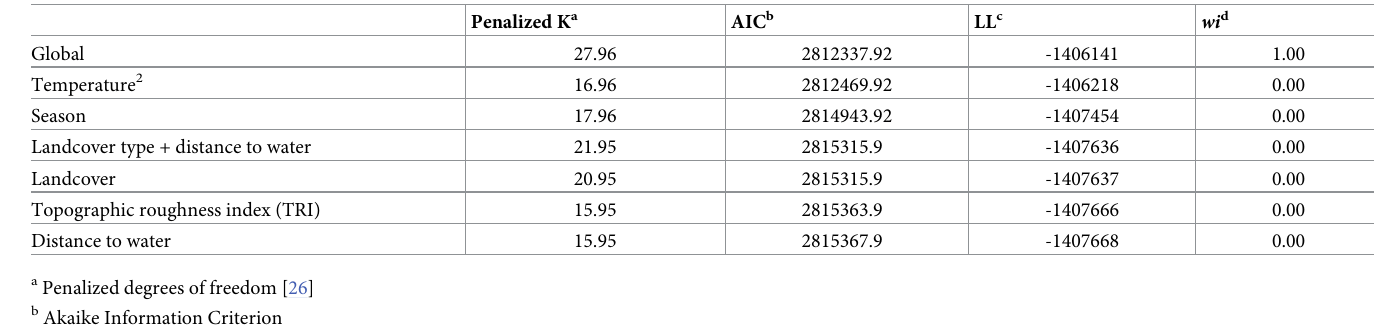
Table 3. Cox proportional hazard model results relating first passage time of GPS-collared wild pigs on Fort Hood Military Installation, Texas, USA in 2016–2017 to explanatory